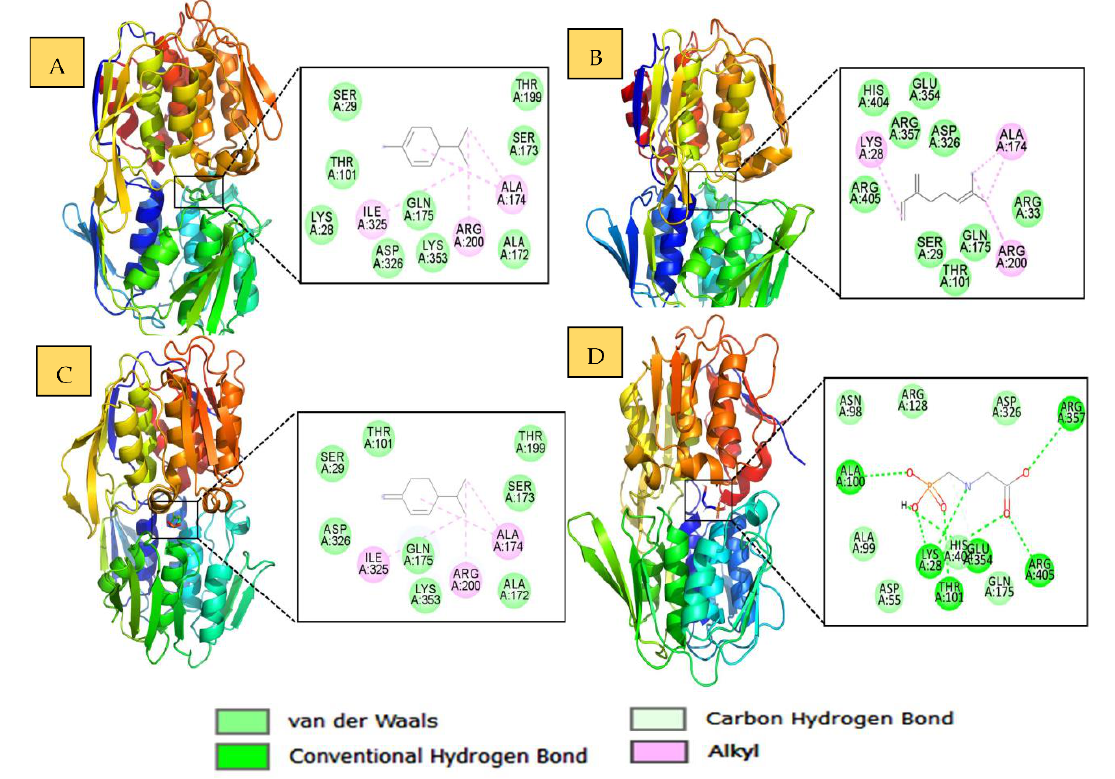
Figure 2. The molecular docking complex of EPSPS synthase (PDB ID: 3FJZ) with ( A ) α-phellandrene, ( B ) β-myrcene, ( C ) β-phellandrene and ( D ) glyphosate are displayed with a rendered cartoon representation on the right with a deep core accommodating the respective ligand, and on the left panel with 2D interaction plots displaying the interactions between the residues of EPSP synthase and ligands indicated by dashed lines.